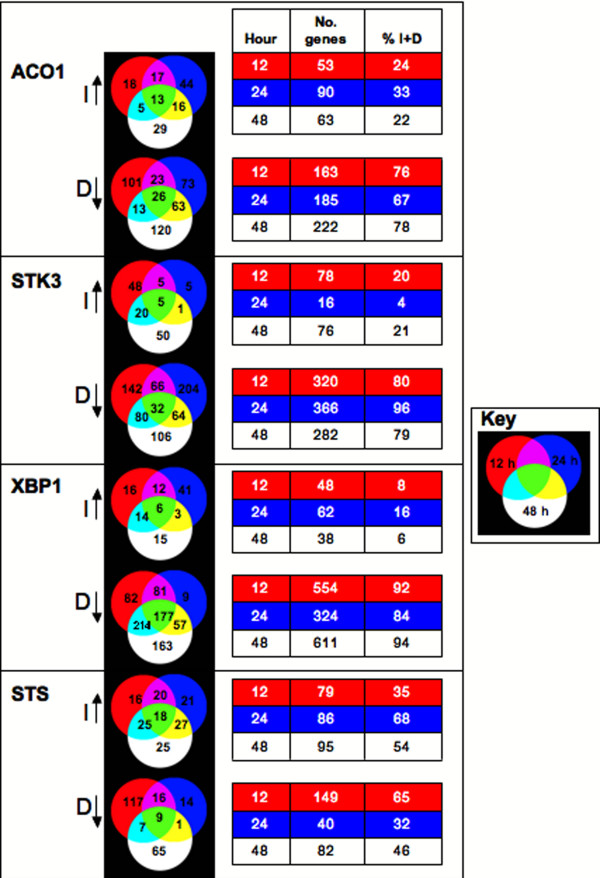
Venn diagrams prepared with the list of 997 differentially expressed transcripts. I↑ and ↓D, number of genes increased or decreased in expression respectively, compared to the mock transfection control at that time point. Venn diagrams, 12 hours (red), 24 hours (blue), 48 hours (white). Boxes; No. genes – gene number increasing or decreasing at that time point, % I+D – percentage of genes increasing or decreasing at that time point.